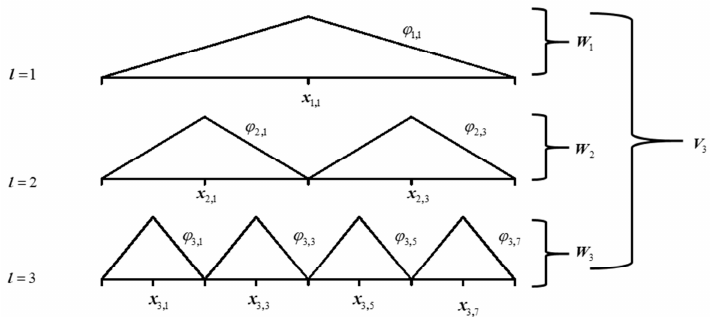
Figure 6. Basis functions and response space for one-dimensional interpolation at l = 3 condition.